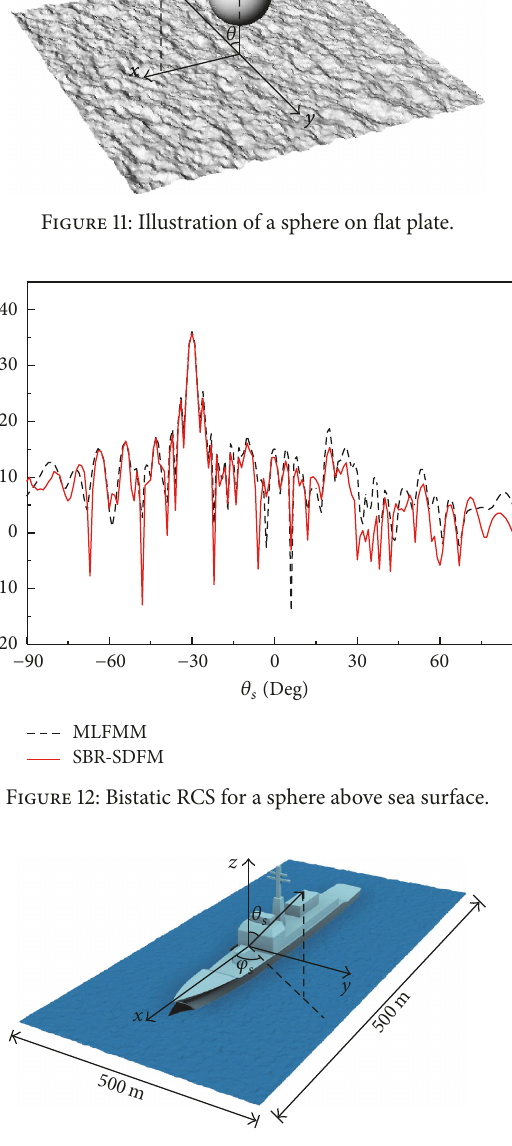
Figure 13: Illustration of the composite model of ship-ocean.